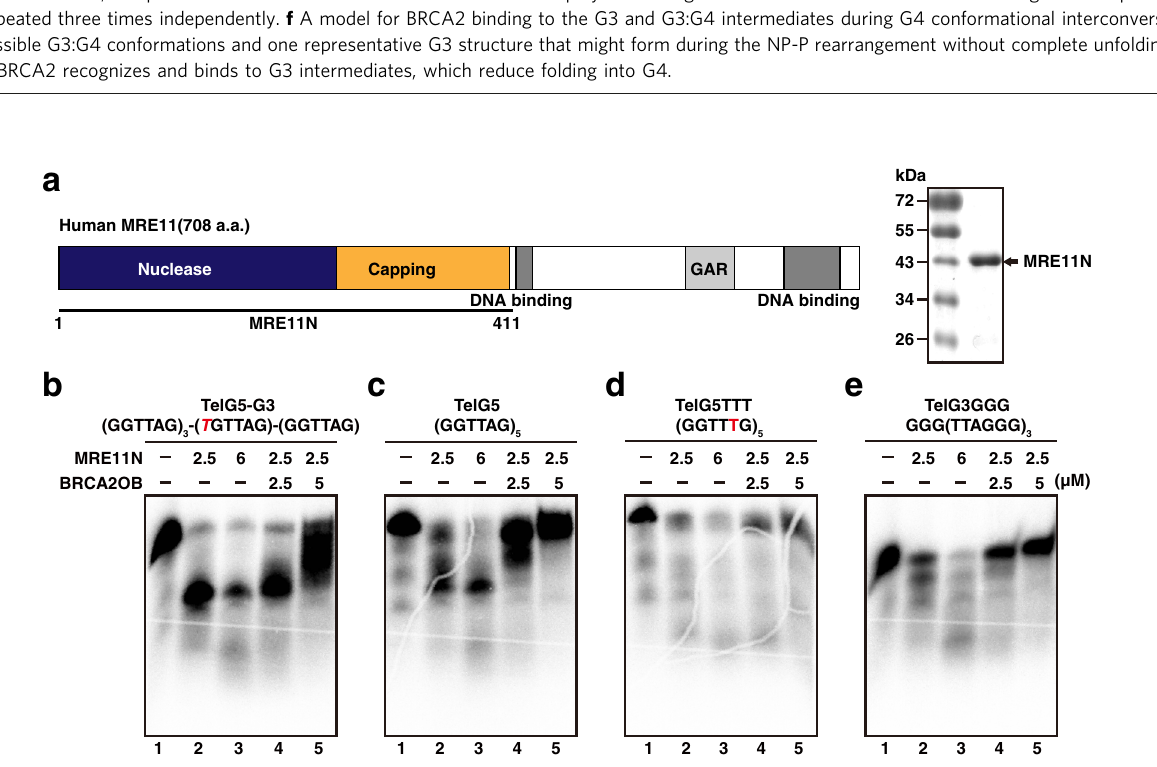
Fig. 5 MRE11 resects G4 telomere. a Schematic representation of human MRE11. The functional domains are marked. Recombinant hMRE11 core (1 – 411 a.a.; MRE11N) was puri fi ed, following the previously published method 62 (SDS-PAGE gel on the right). Functionality of the puri fi ed protein was assessed (Supplementary Fig. 14) and employed in the nuclease assay. b , c , d , e Denaturing PAGE gels showing nuclease activity of MRE11N (lane 2-3) and the effect of BRCA2OB towards various telomere G4 and G3 variants (lane 4-5). 2.5 μ M or 6 μ M of MRE11N was incubated with indicated DNA substrates: b TelG5- G3; c TelG5; d TelG5TTT; e TelG3GGG for nuclease assay. Increasing concentrations of BRCA2OB were employed to assess the inhibition of MRE11- mediated resection. The result is the representative of three independent